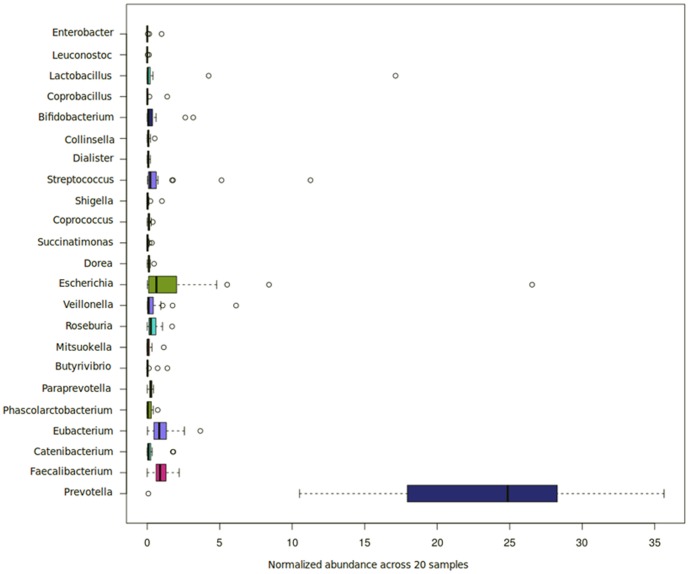
Variation of the normalized abundances (expressed as percentages) of the 23 core genera across the 20 gut metagenomes.